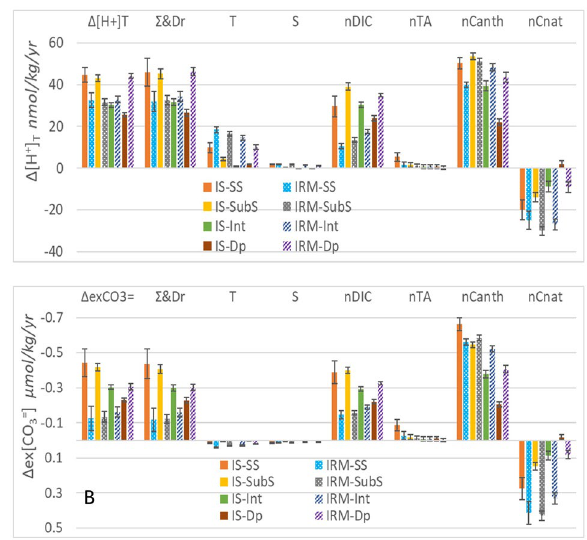
Figure 6. Acidification trends and drivers decomposition (T,S, nDIC and nTA) for the seasonally detrended average time series of total hydrogen ions concentration in pmol/kg/yr (Δ [H + ] T , A ) and for excess of [CO 3 = ] over the [CO 3 = ] at aragonite saturation in µmol/kg/yr (Δ ex[CO 3 = ] , B ). The nDIC driver trends is split in natural (nCnat) and anthropogenic components (nCanth). The colour code is shown on both